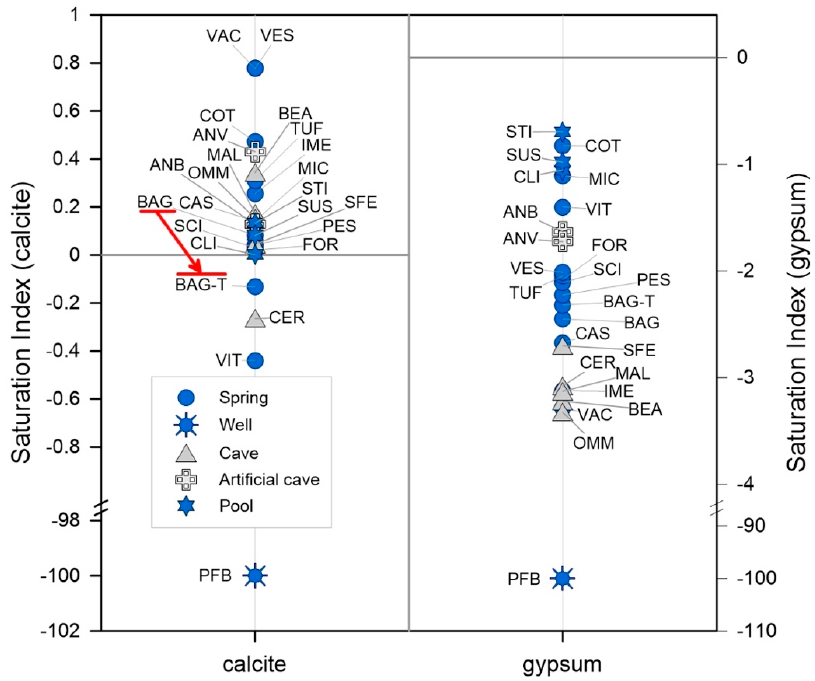
Figure 5. Saturation Indexes of calcite and gypsum calculated using the PHREEQC software [35].